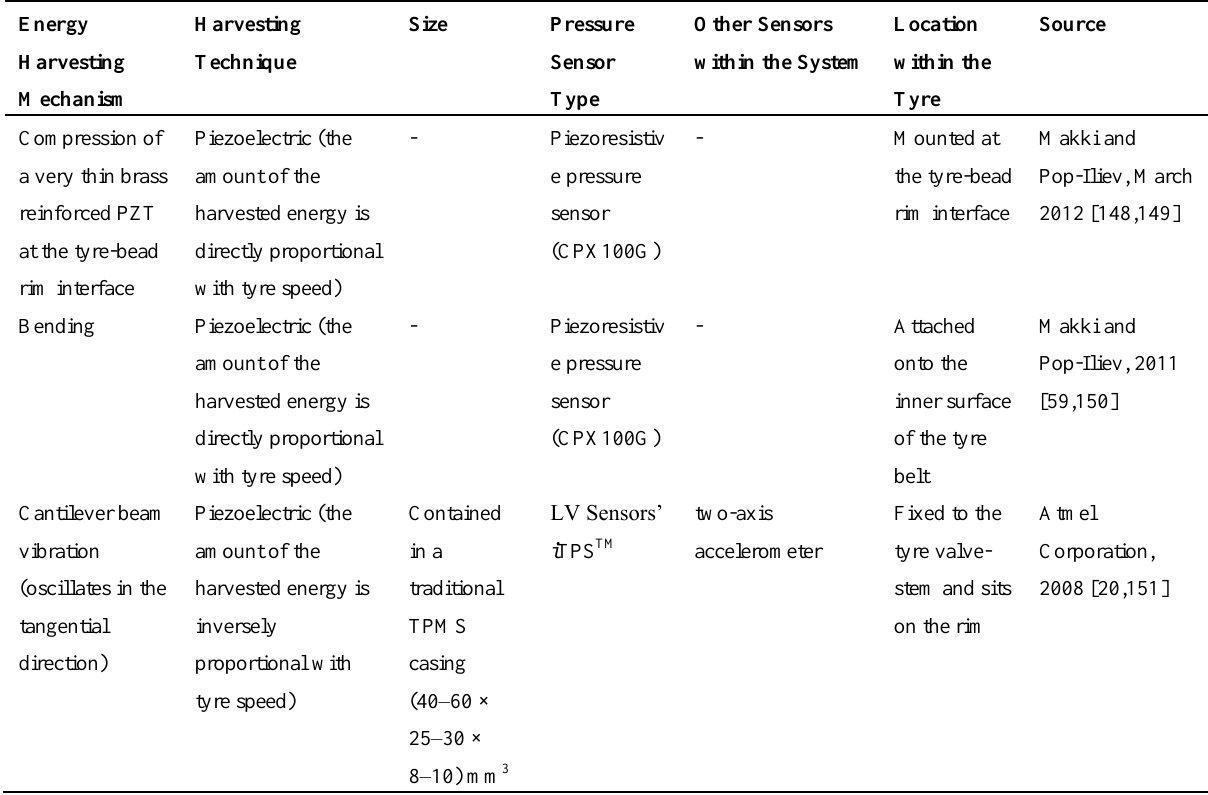
Table 4. Summary of published research for self-powered TPMS using various energy harvesting means.